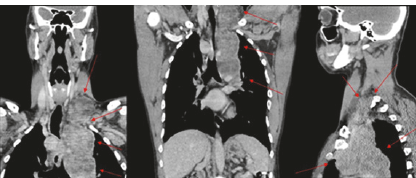
Figure 3: Chest tomography in coronal and sagittal sections demonstrating enlargement of the cervical and supraclavicular lymph node in the left. It also shows mediastinal masses and their extension (red arrows).